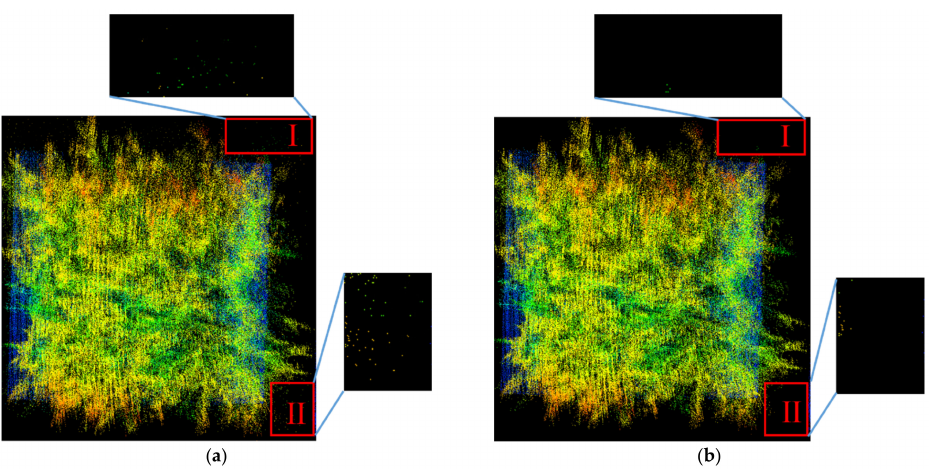
Figure 9. Noise reduction of Sample-set 2 from the random experiment group: ( a ) without noise reduction and ( b ) after noise reduction.